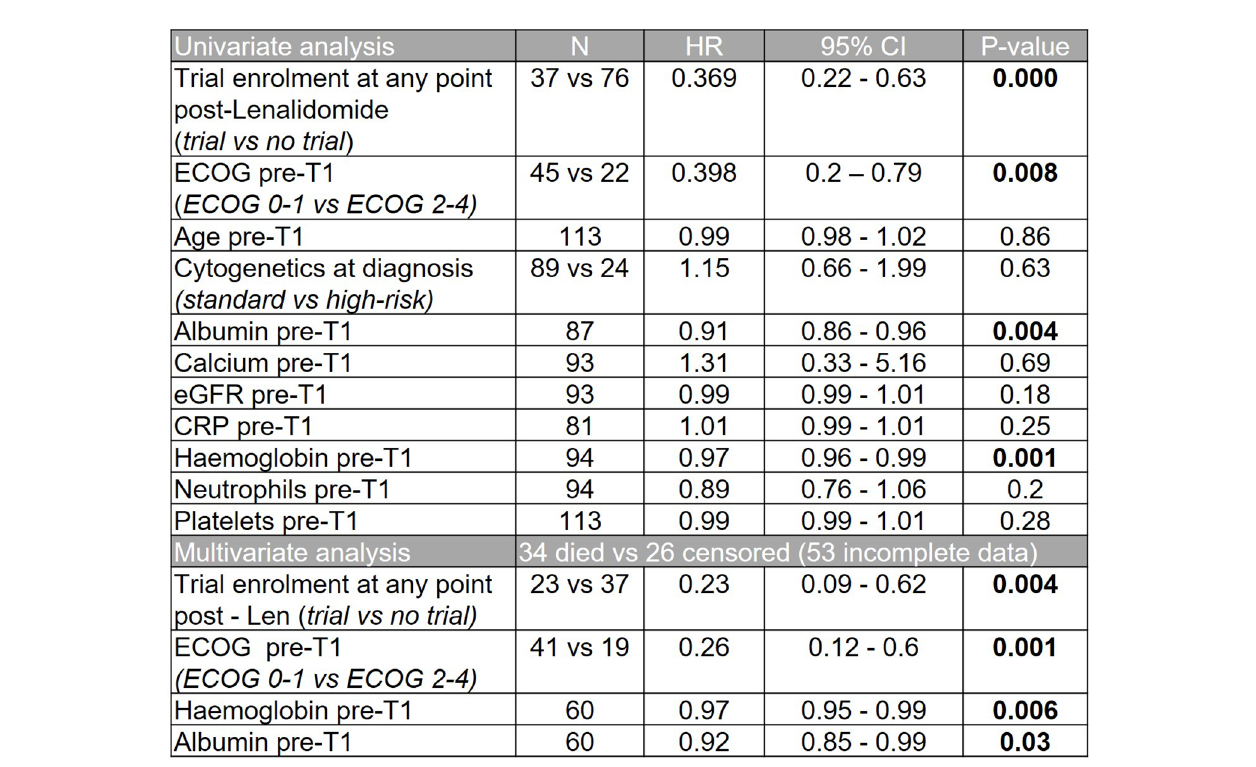
FIGURE 6 | Univariate and multivariate analyses showing impact of patient variables on overall survival from